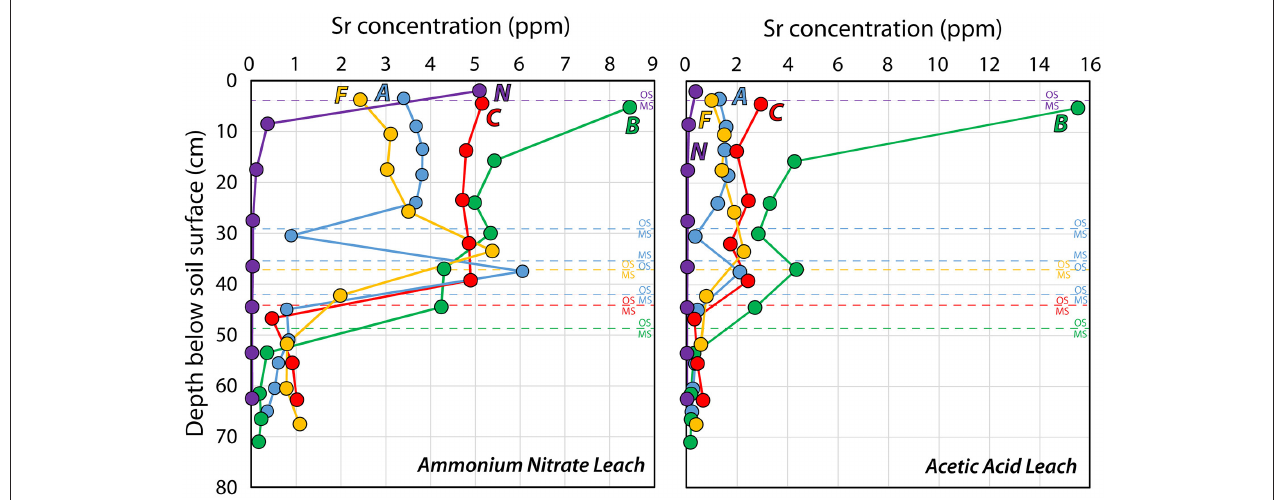
FIGURE 4 | Strontium concentrations in ammonium nitrate- and acetic acid leachates from the five soil profiles; (A, B, C) from the liming test site, the farmland Profile F and the heathland Profile N. See Figure 1 for locations of soil